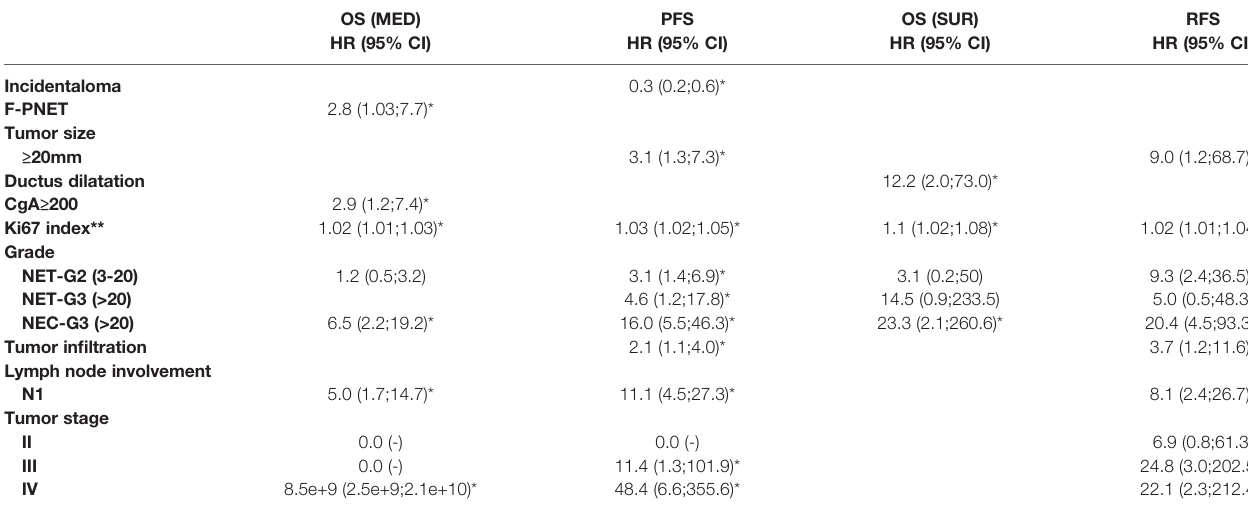
TABLE 3 | Kaplan-Meier survival analysis in 174 patients with pancreatic neuroendocrine tumors divided into surgically treated (SUR group, n = 91) and medically treated or non-treated (MED group, n =